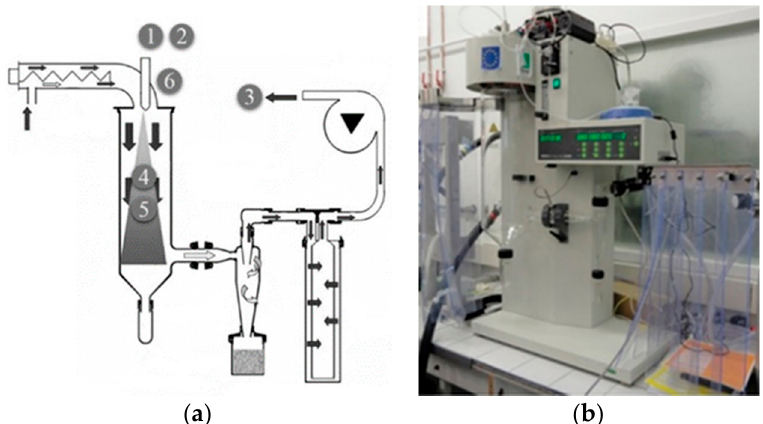
Figure 1. ( a ) Schematic view of the spray-drying (SD) experimental setup. Tunable parameters are positioned and labeled: 1 viscosity of the initial liquid, 2 initial iron (II) and ligand concentrations, 3 suction flow, 4 air flow, 5 drying temperature, and 6 design of the nozzle; ( b ) view of the SD setup Büchi B-290 used in the laboratory.